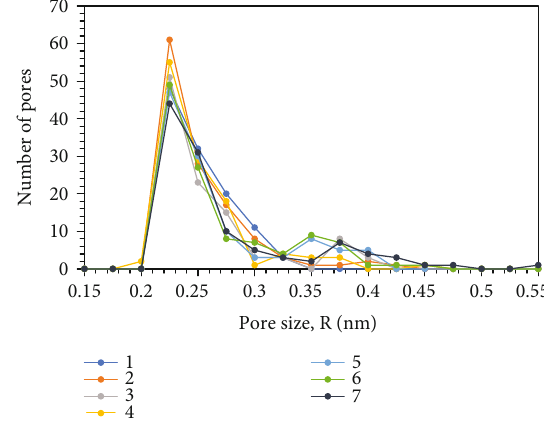
Figure 4: PSD of the kerogen con fi